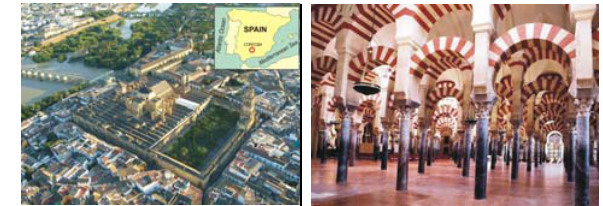
Figure 1. Left: aerial view of Historic Centre of Cordoba with the Cathedral-Mosque (centre of the image) near the Roman Bridge on Guadalquivir River. Right: hypostyle hall with horseshoe arches.